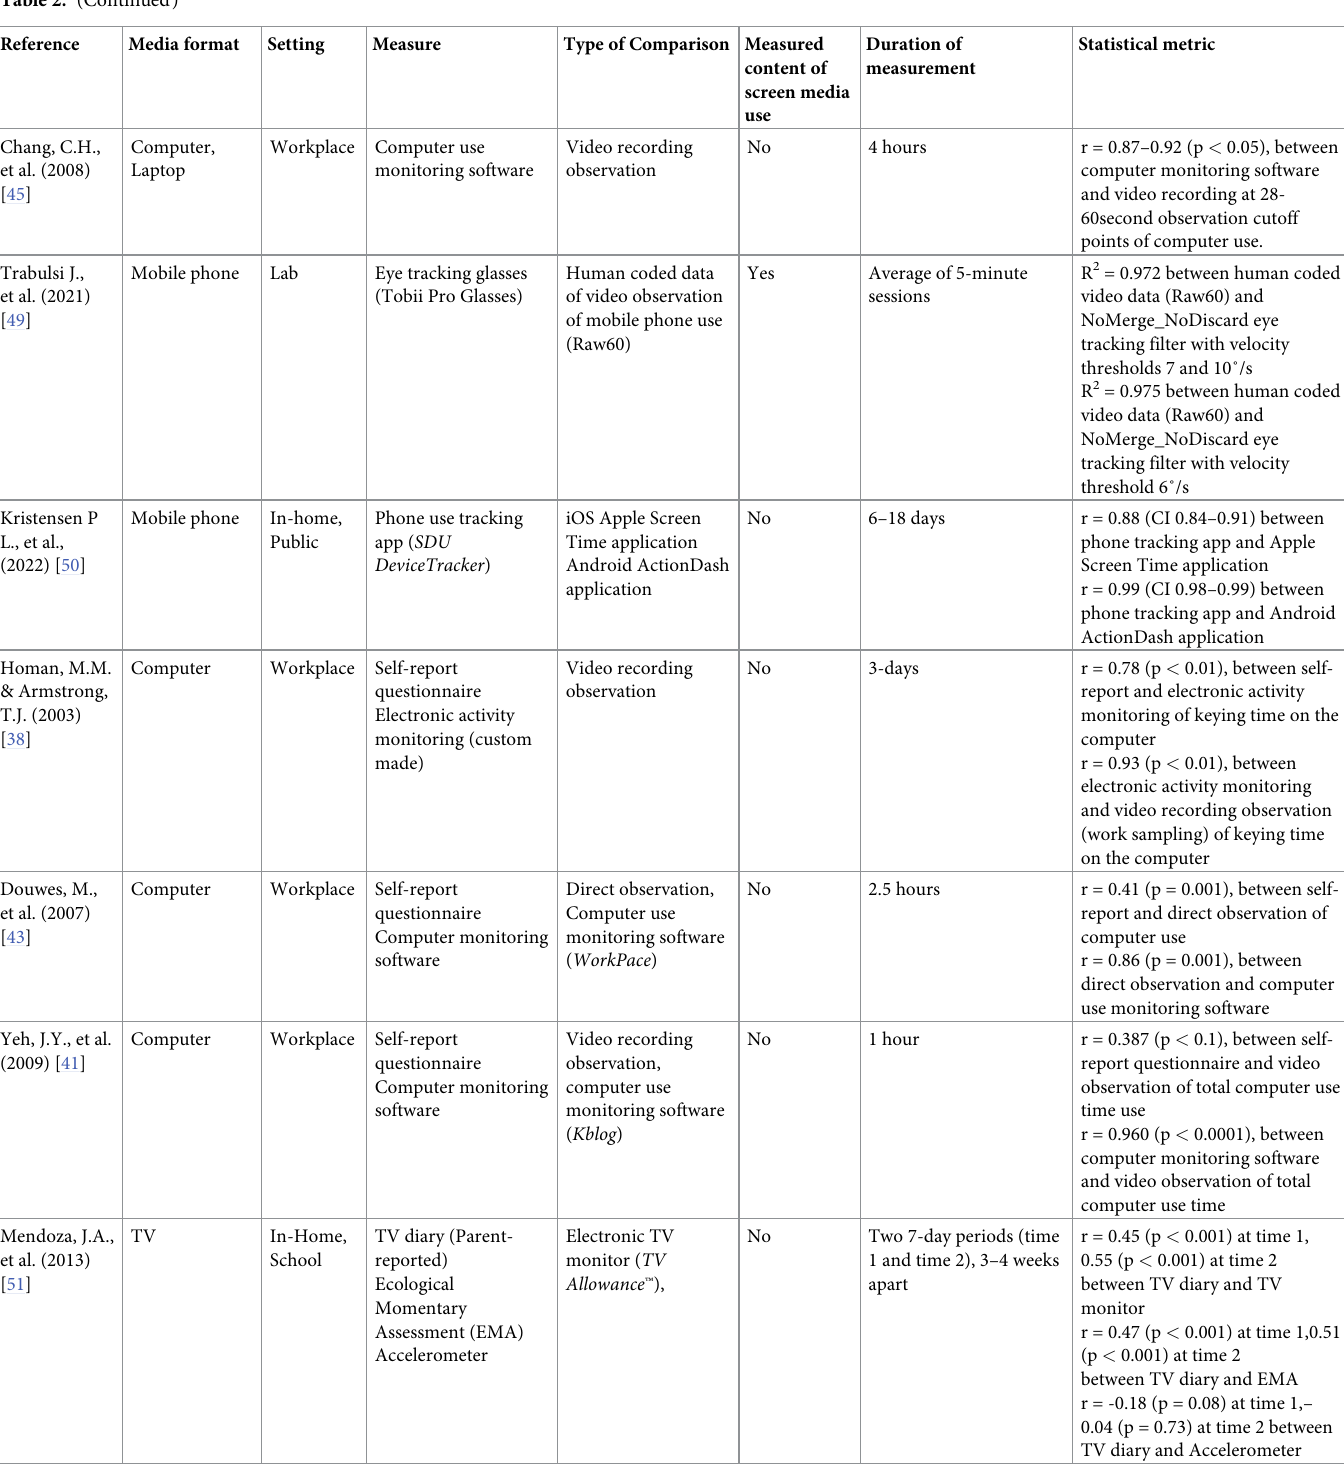
Note: Table 2 is organized by media format measured, then chronologically, then alphabetically. The results are sorted into three groups according to the type of measures compared: self-report, technology-based, or a combination of the